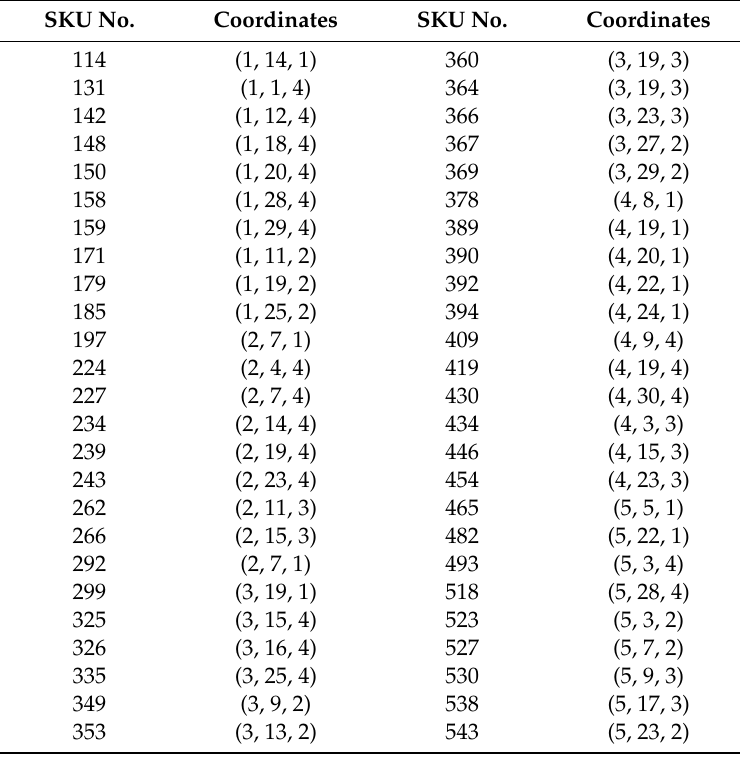
Table A1. List of partial retrieval tasks.